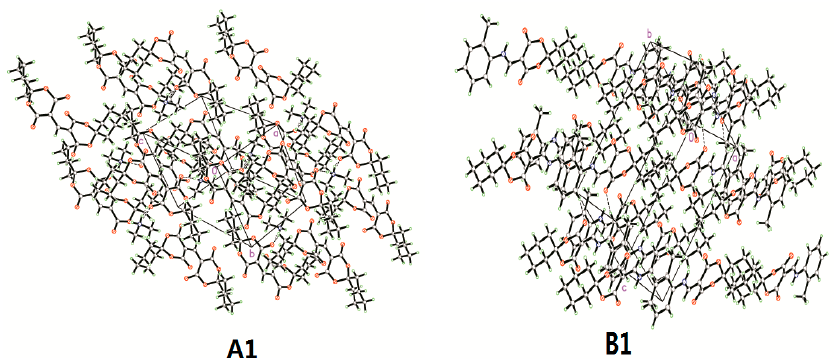
Figure 3. The packing representation of A1 and B1 .